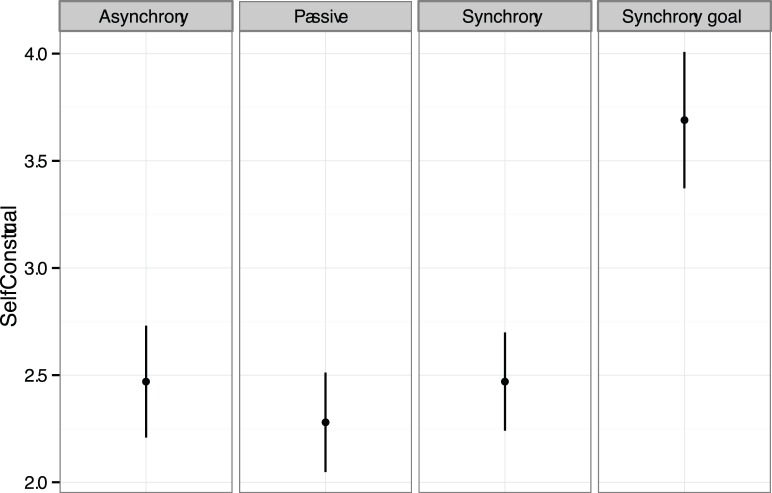
Interdependent self-construal across experimental conditions for Experiment 1.Each dot represents the mean rating for interdependent self-construal. Error bars are +/− SE.